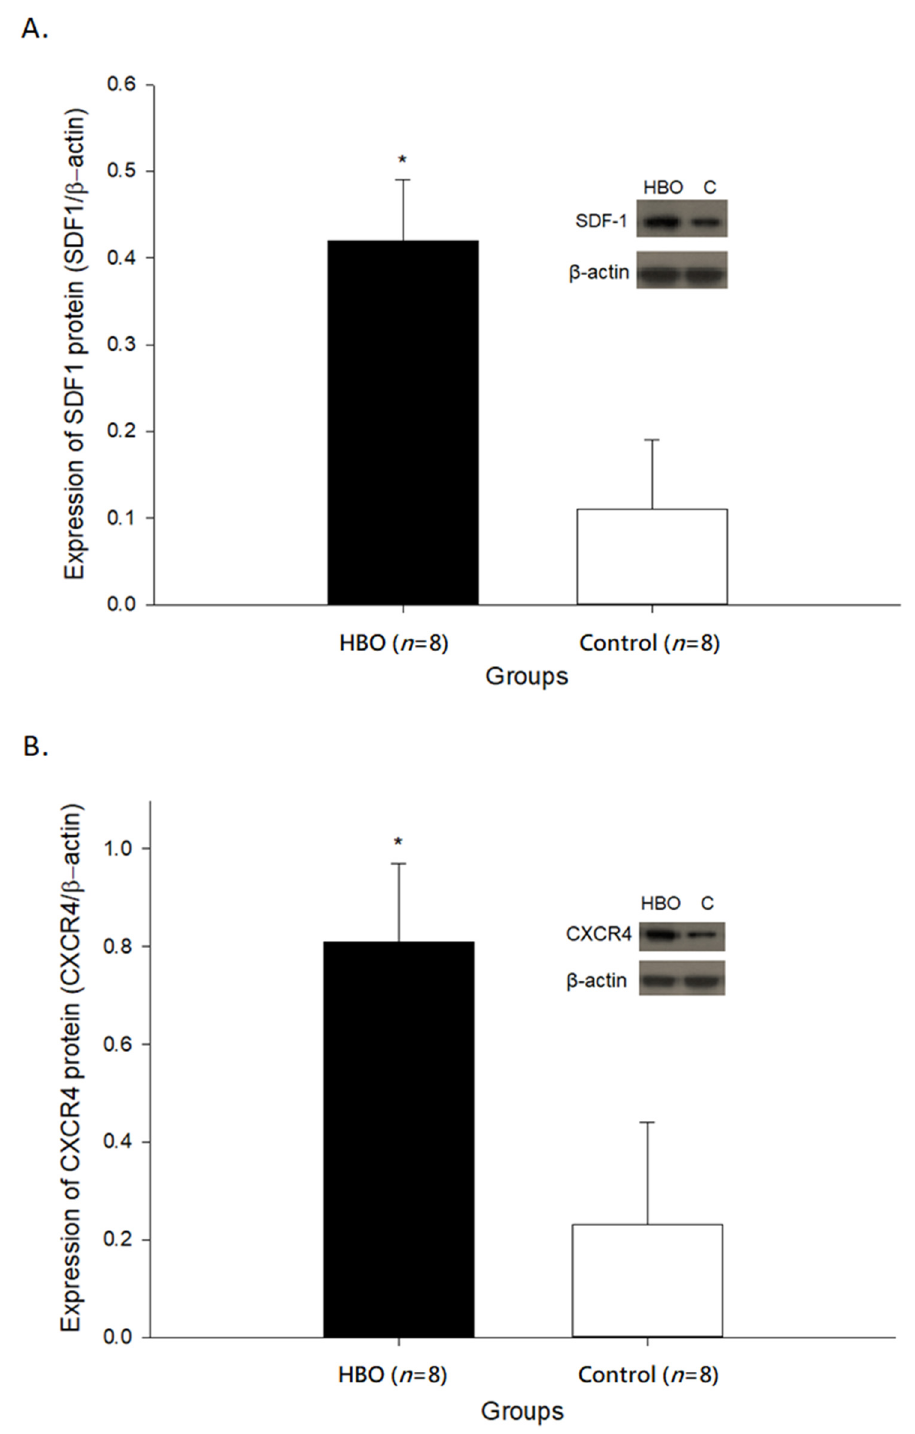
Figure 2. ( A ) The expressions of SDF1 in the affected motor cortex between groups. ( B ) The expres- sions of CXCR4 in the affected motor cortex between groups. *, p < 0.05. C: control; HBO: hyperbaric oxygen; SDF1: Stromal cell-derived factor 1; CXCR4: CXC chemokine receptor 4.